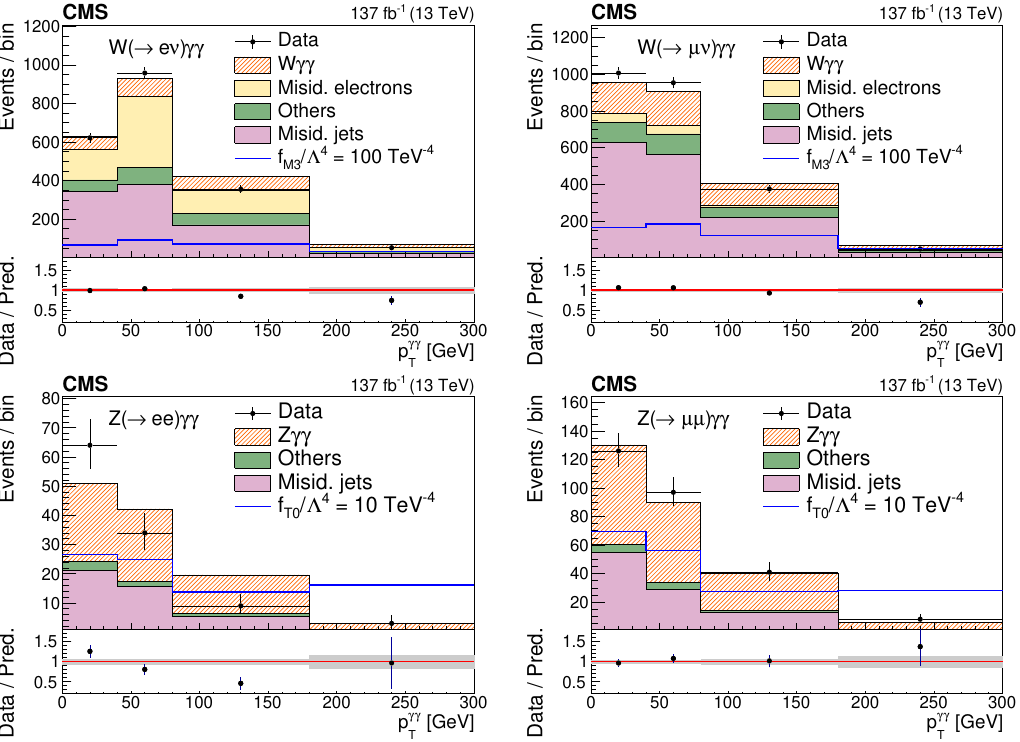
Figure 2 . Distribution of the transverse momentum of the diphoton system for the W gg electron (upper left) and muon (upper right) channels and for the Z gg electron (lower left) and muon (lower right) channels. The predicted yields are shown with their pre-fit normalisations. The black points represent the data with error bars showing the statistical uncertainties. The hatched histogram shows the expected signal contribution. The background estimate for electron (jet) misidentified as photons, obtained from control samples in data, is shown in yellow (purple). The remaining background, derived from MC simulation, is shown in green. In the ratio plots, the grey hashed area is the statistical uncertainty on the sum of signal and backgrounds, while the uncertainty in the black dots is the statistical uncertainty of the data. In blue, the expected distribution for an example value of the anomalous coupling parameters f / Λ 4 and f / Λ 4 is also shown (see M3 T0 section 8 for the